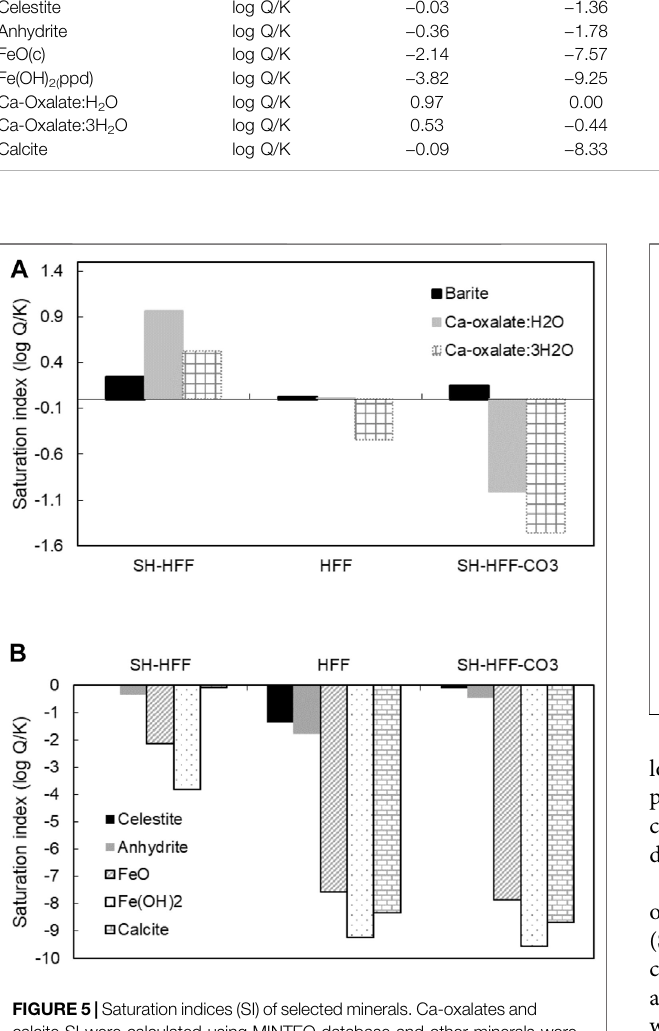
FIGURE5| Saturationindices(SI)ofselectedminerals. Ca-oxalatesand calcite SI were calculated using MINTEQ database and other minerals were calculated using Pitzer database. The temperature of experimental groups is 100 ° C.